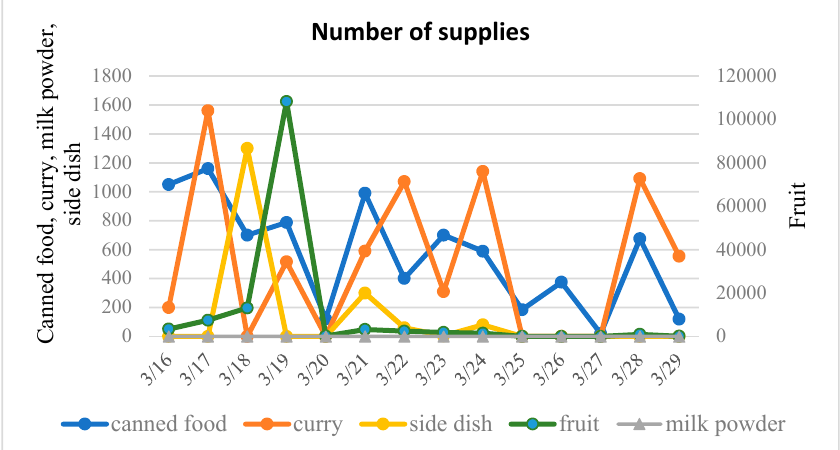
Figure 4. Supply of wheat-based commodities.